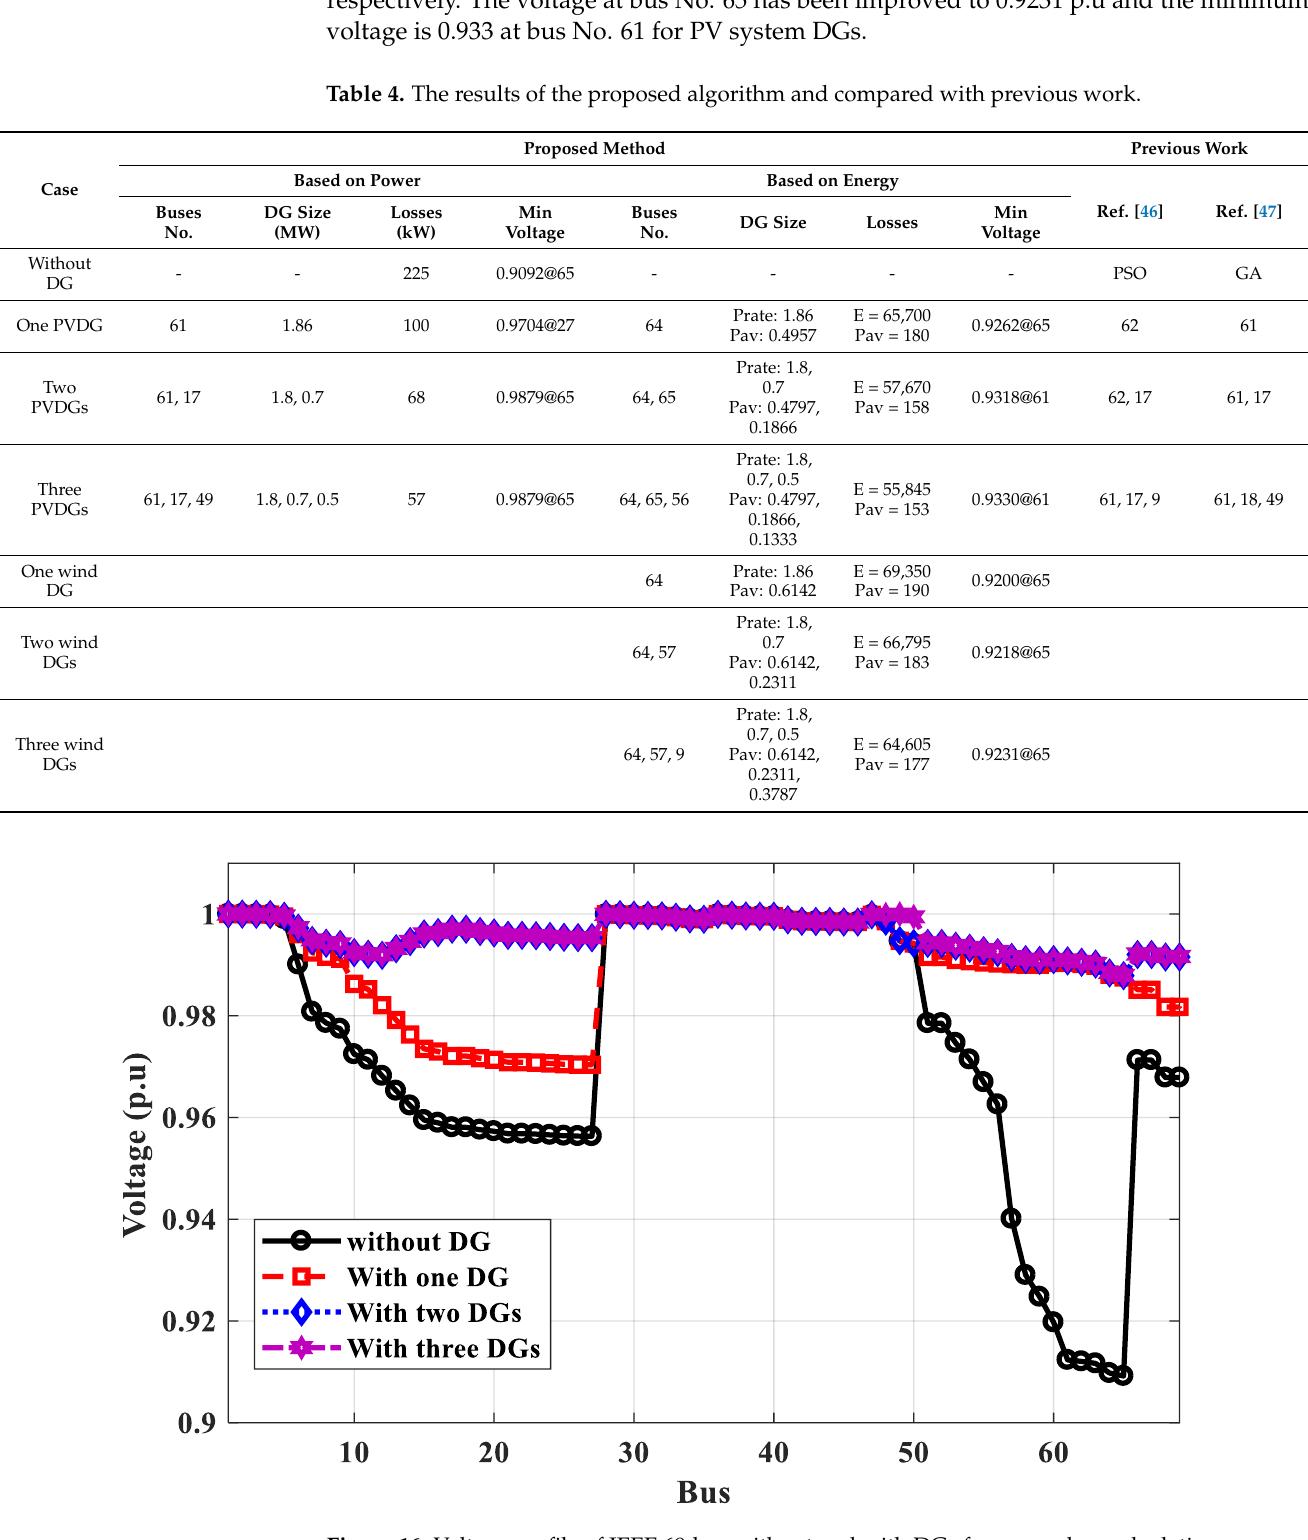
Table 4. The results of the proposed algorithm and compared with previous work.